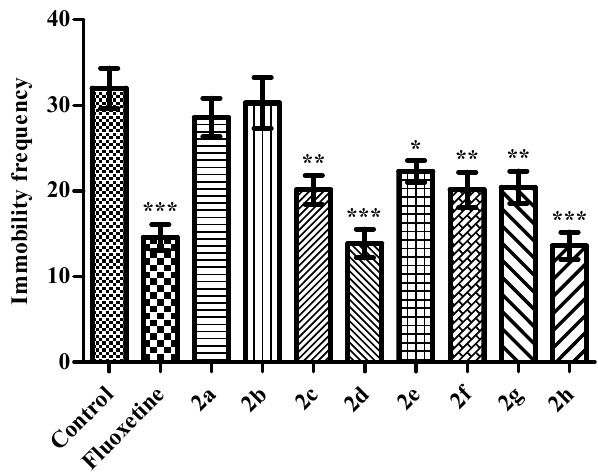
Figure 3. The effects of the test compounds ( 2a – 2h ) and fluoxetine on the immobility frequencies of the mice in MFST. Significant differences against control group, * p < 0.05, ** p < 0.01, *** p < 0.001. Values are presented as mean ± SEM, ( n = 7).